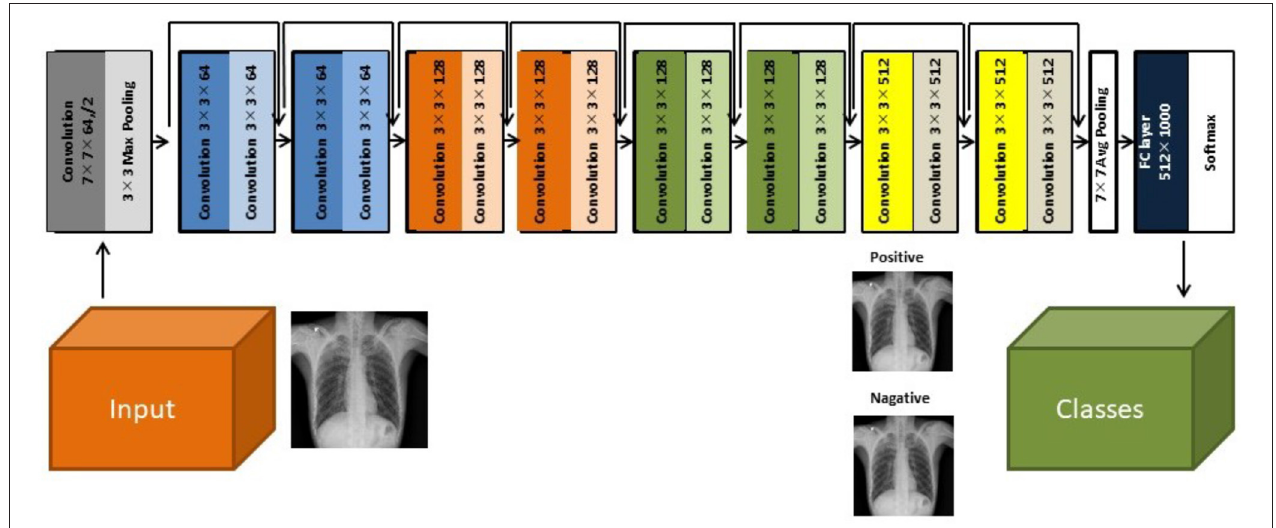
FIGURE 2 | The architecture of the ResNet18 convolutional neural network model (28).